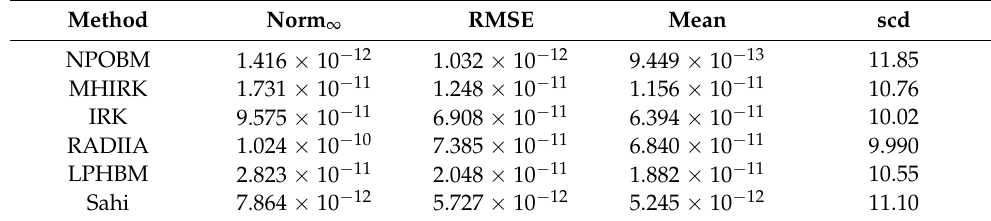
Table 11. Numerical results for Problem 3 with NS = 2 8 where x ∈ [ 0,5 ] .